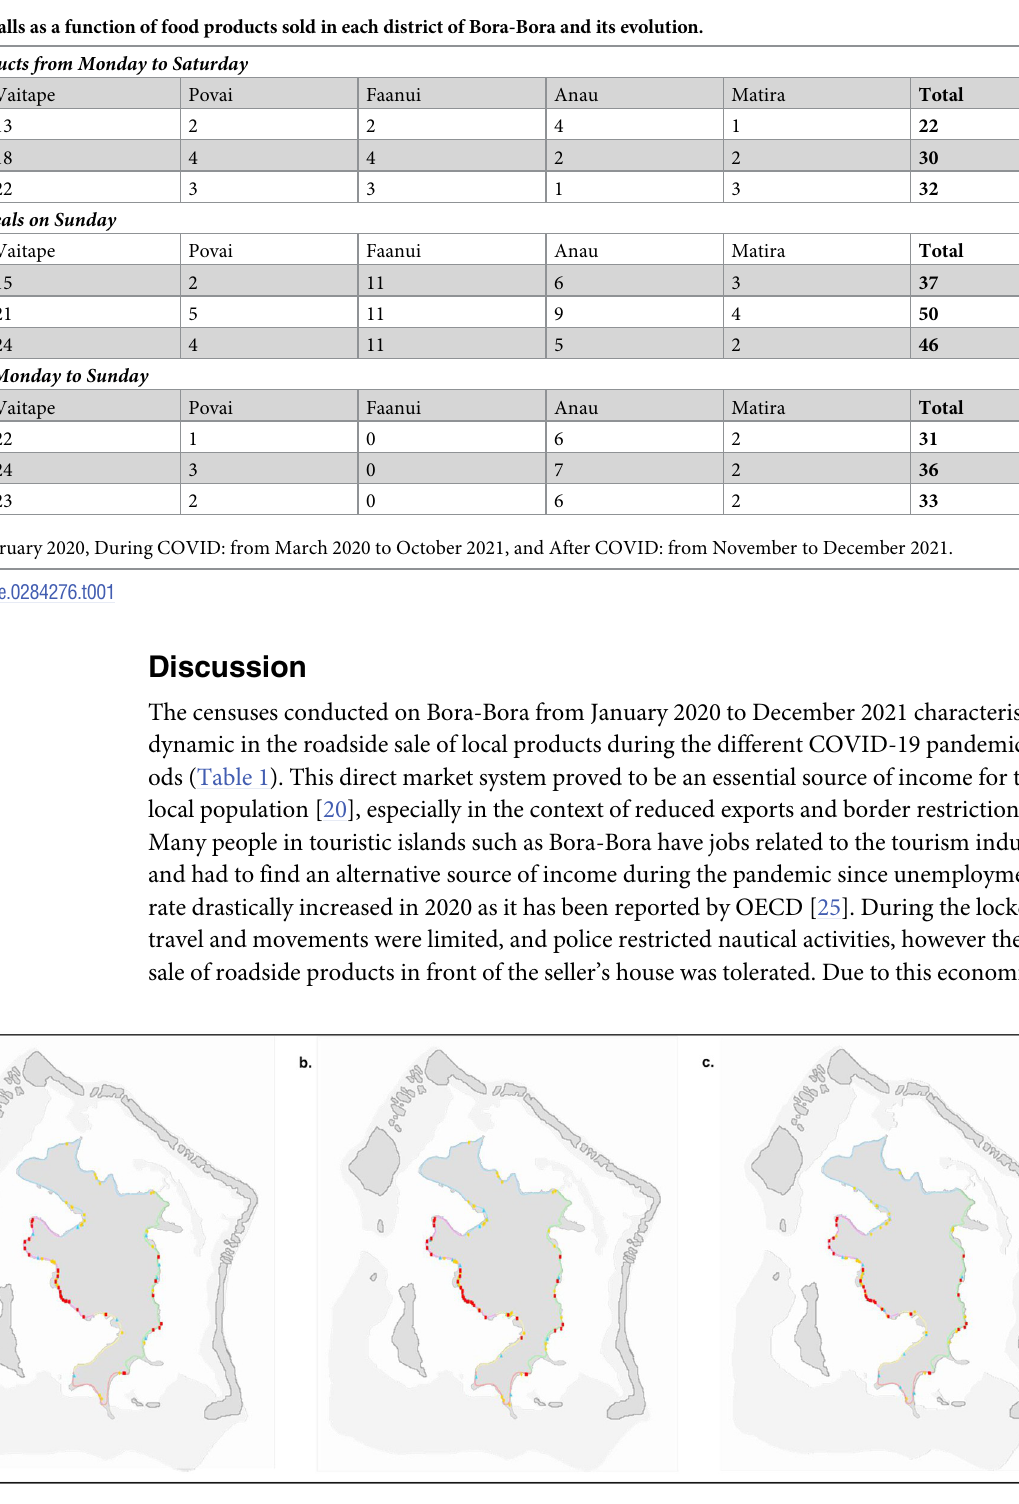
Fig 3. Map of Bora-Bora showing the locations of the roadside stalls before (a), during (b) and after (c) the pandemic. Stands of land products are represented by blue triangles, stands of cooked meals are represented by yellow circles and stands of fish are represented by red squares. Reprinted